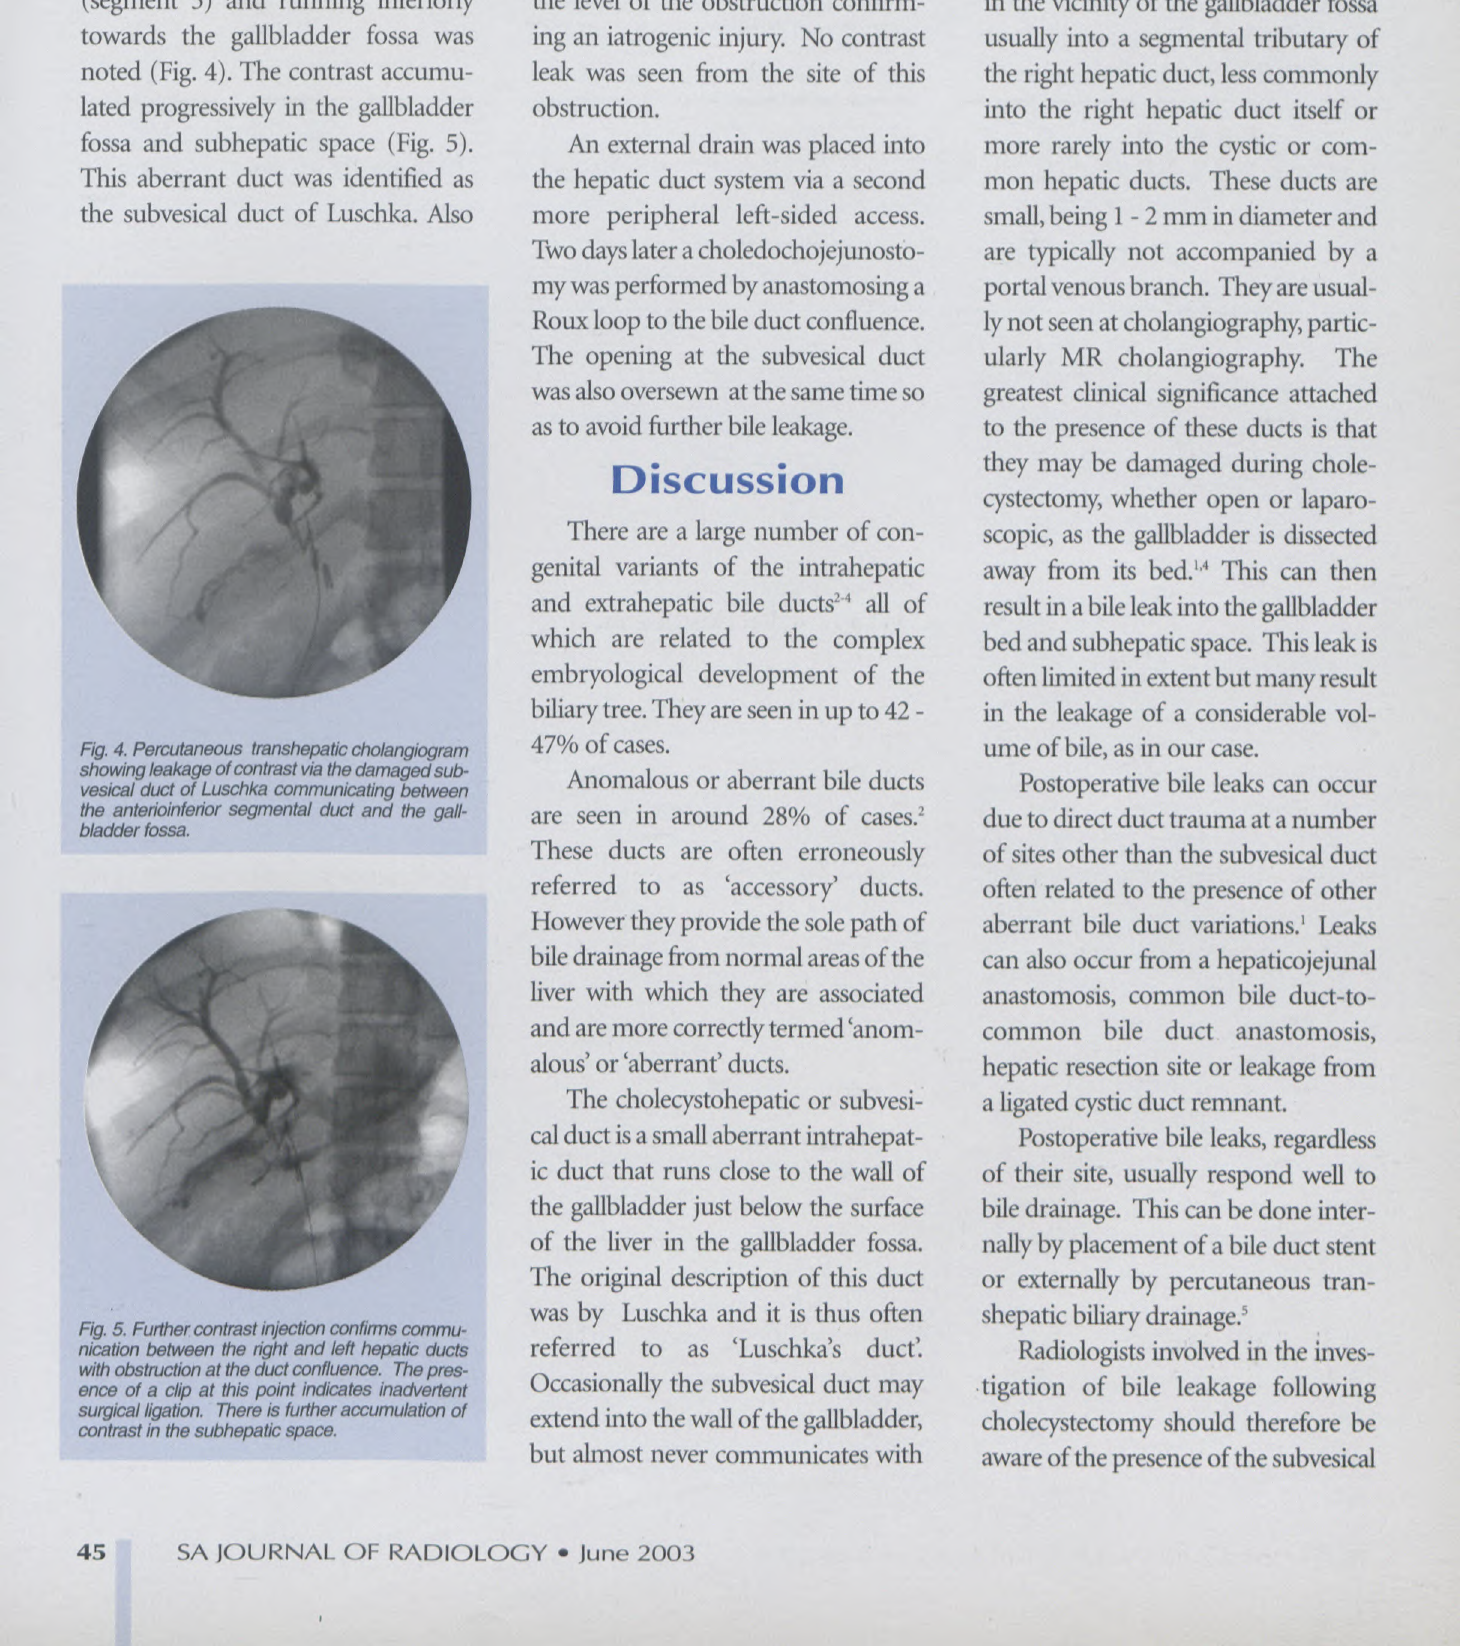
Fig. 5. Further contrast injection confirms commu- nication between the right and left hepatic ducts with obstruction at the duct confluence. The pres- ence of a clip at this point indicates inadvertent surgical ligation. There is further accumulation of contrast in the subhepatic